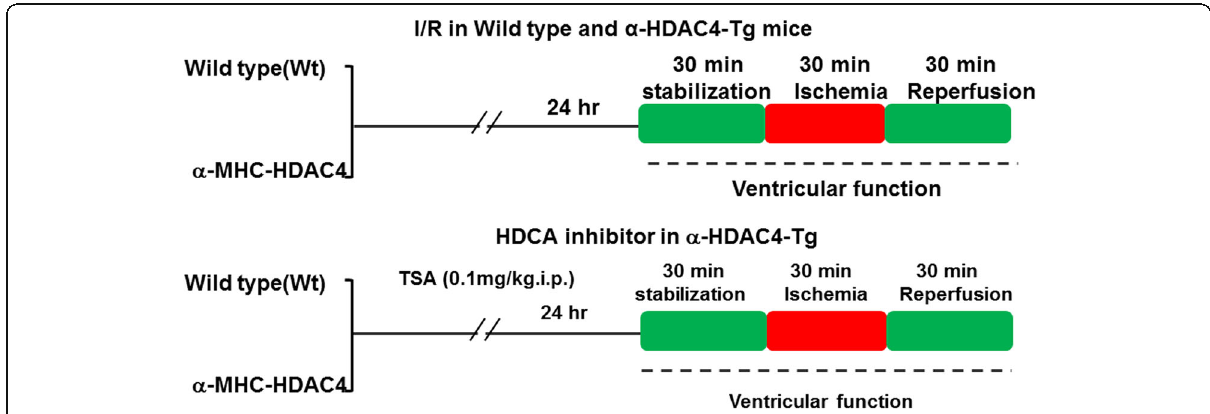
Fig. 3 The experimental protocol for myocardial I/R. Wt: wild-type, TSA: trichostatin A; I/R: